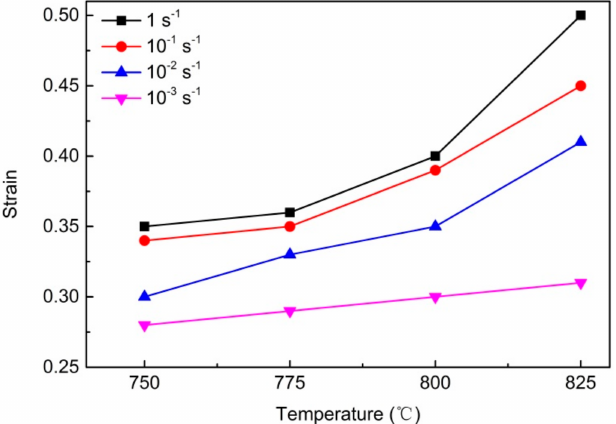
Figure 4. Relationship between the ε m corresponding to the maximum of − d σ /d ε and the deformation